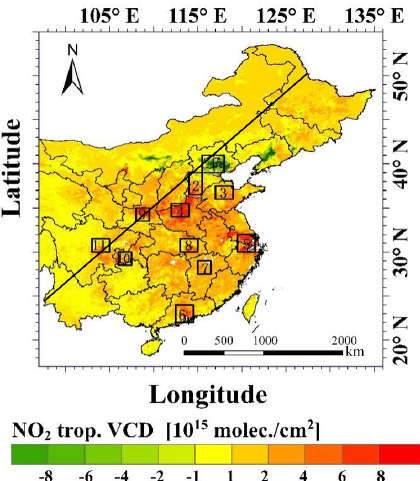
Figure 1. Study area showing the NO 2 TVCD difference map for week 12 (i.e., NO 2 TVCD for week 12 minus NO 2 TVCD for week 0). The 11 focus regions are indicated with numbers, corresponding to their names and coordinates which are listed in Table 1. The black diagonal line is the Hu line (Chen et al.,